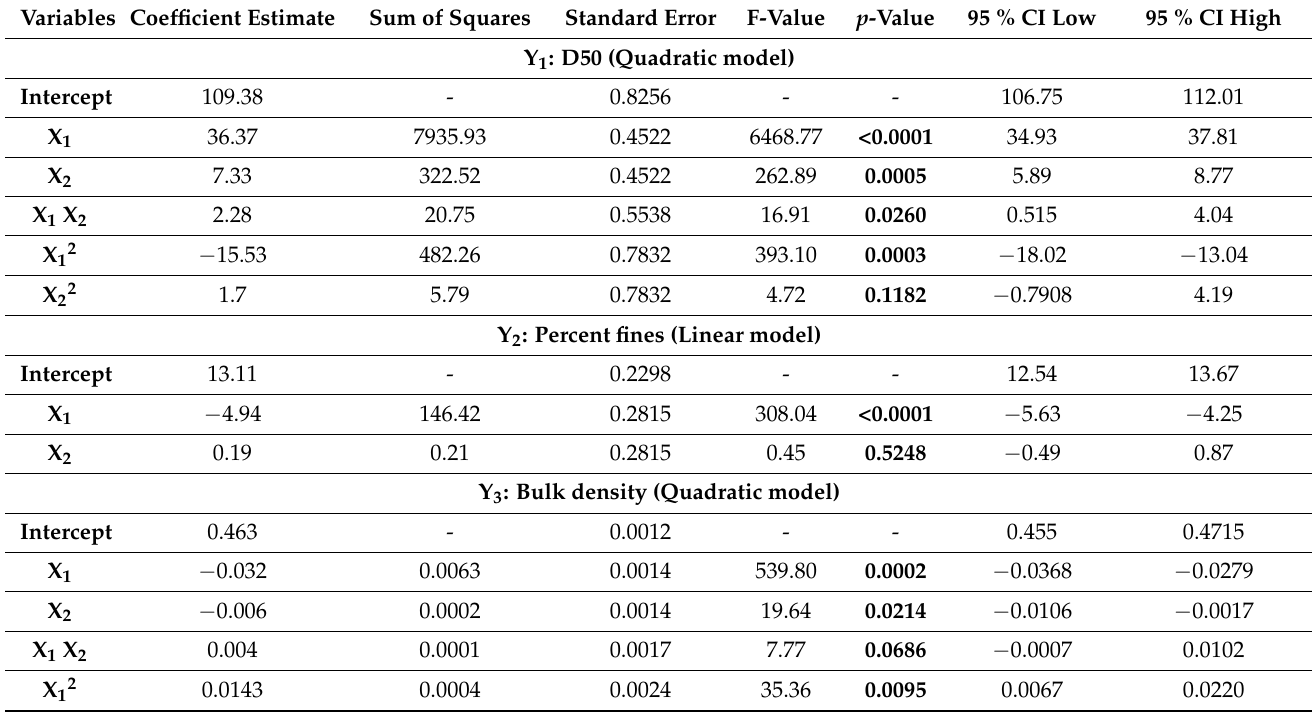
Table 6. Regression analysis of granules measured